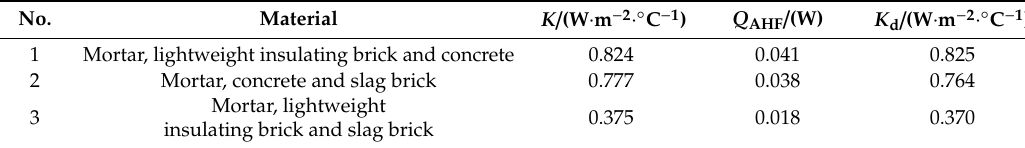
Table 2. Results of theoretical calculation method and the derived calculation